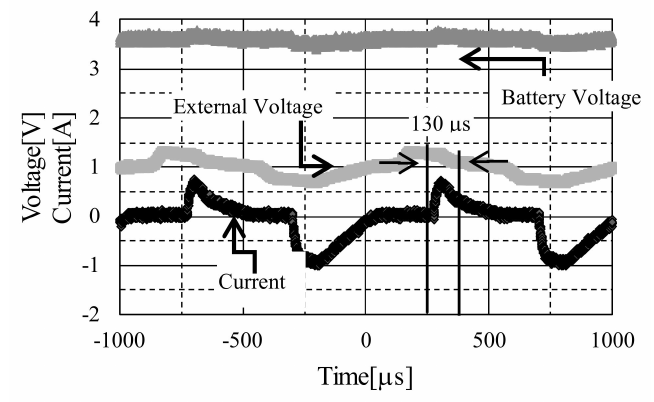
Figure 4. Voltage response of a Li-ion battery to an arbitrary current of 1 kHz